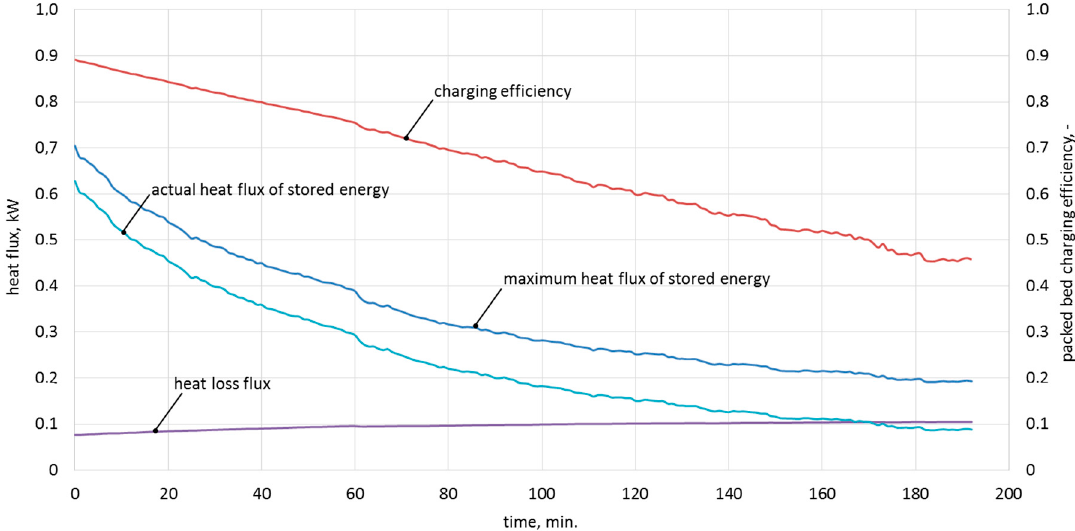
Figure 8. Characteristics of the maximum and actual heat flux, heat loss, and charging efficiency in the function of time for experiment No. 9.